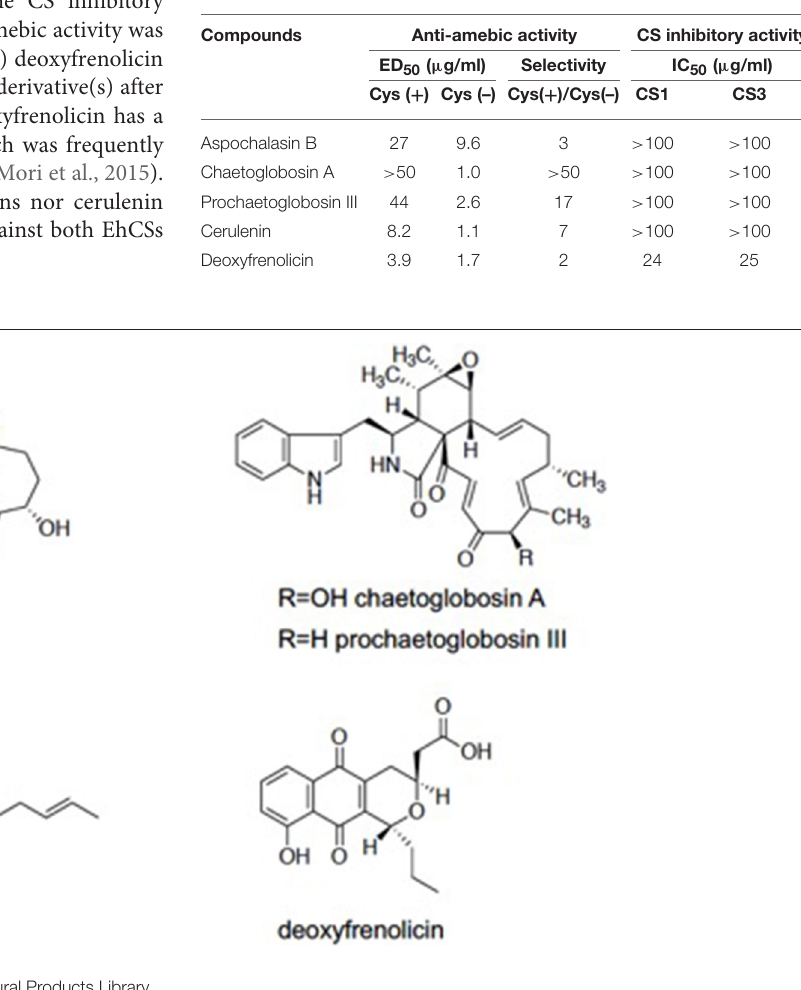
Frontiers in Cellular and Infection Microbiology |